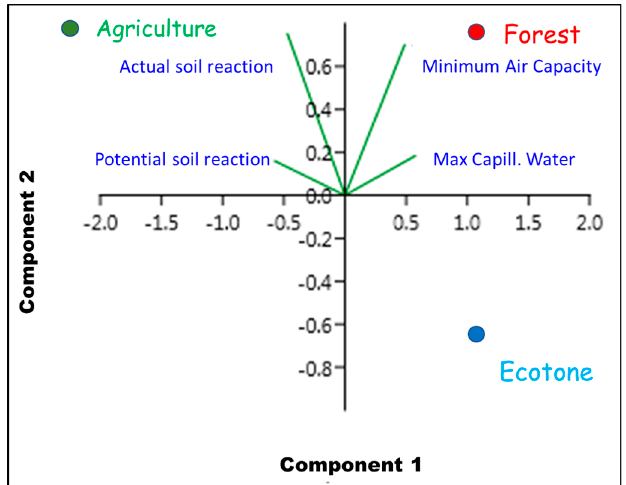
Figure 4. PCA run on values of a potential soil reaction, actual soil reaction, minimum air capacity, and maximum capillary water capacity, after being obtained from an experiment run on three different locations (forest, ecotone, and agriculture sites). Correlation of the variables with components 1 and 2, PC1 = 83.25%, and PC2 = 16.74%. In this case, green dots represent the agriculture land. Red dots represent the forest, and blue dots represent ecotone.